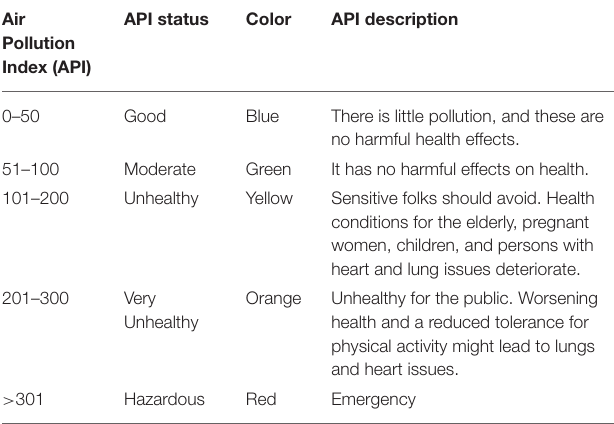
TABLE 9 | Ambient air quality standard in Malaysia by Department of Environment (DoE), Malaysia (